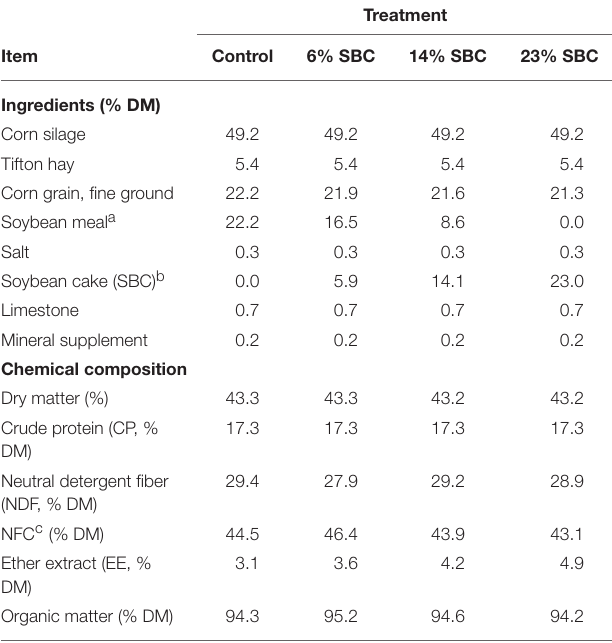
TABLE 1 | Ingredients and chemical composition of diets.